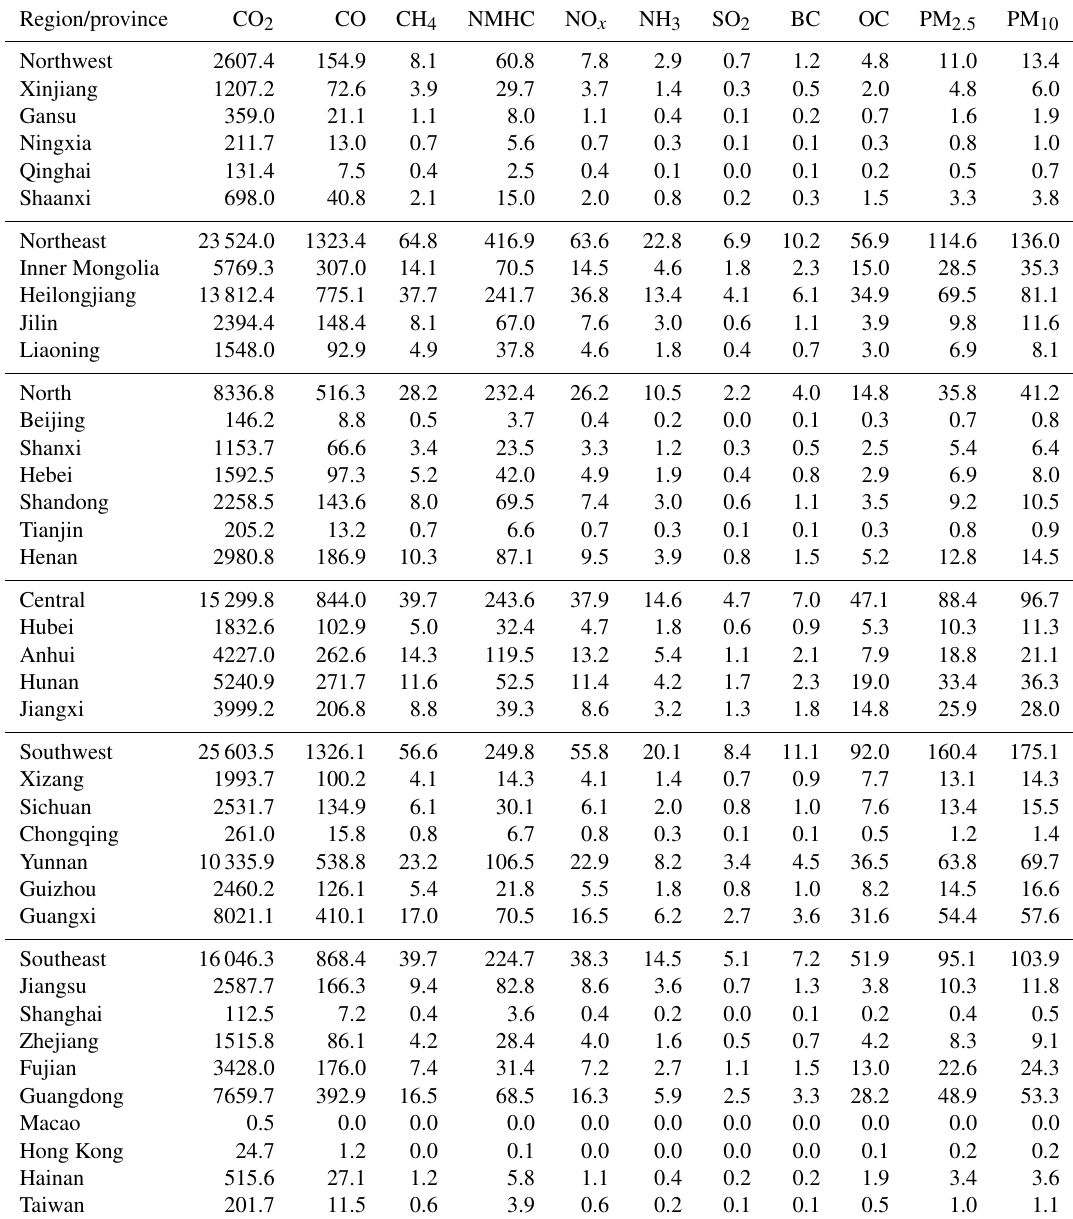
Table 2. Average biomass burning emissions (Gg) in each province from 2003 to 2017.